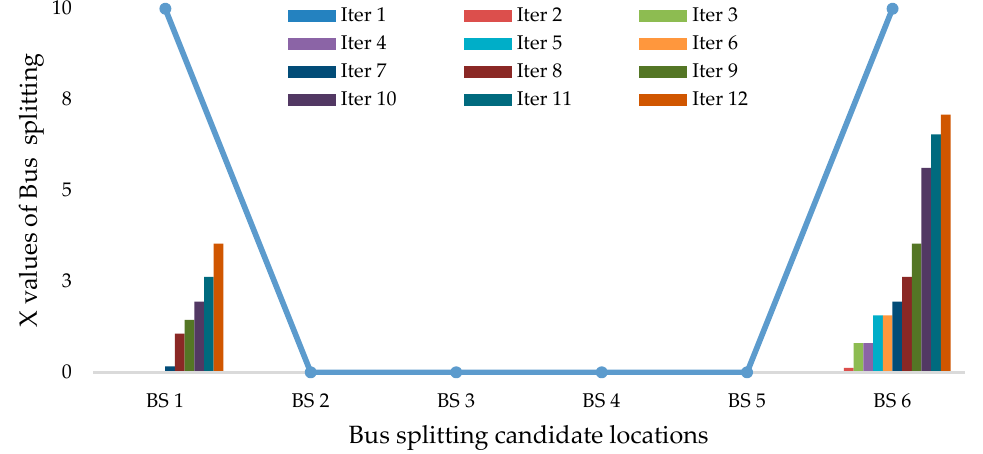
Figure 7. Set of Bus splitting 𝑋 variables at each iteration in Case 2.